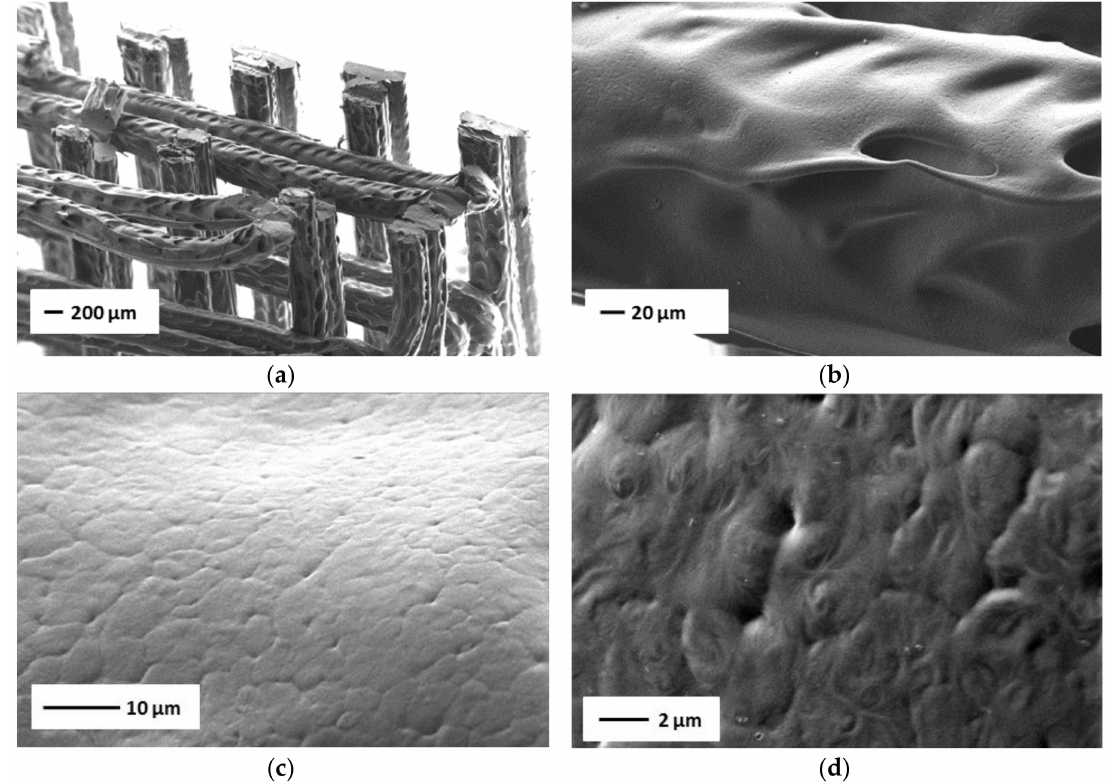
Figure 8. SEM images of 3D printed structures prepared from TPU-(PCL 5 -PEG 10 -PCL 5 ) in the dry state at different magnifications. ( a ) overview of a printed structure, ( b – d ) images of the surface of the printed structure at higher